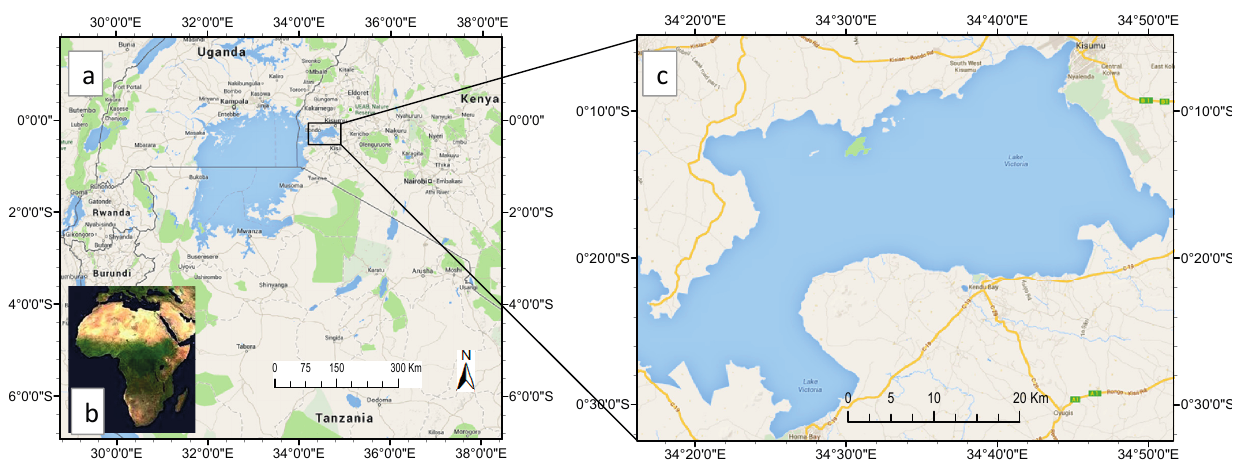
Figure 1. Geographic location of Lake Victoria in East Africa ( a ) and Africa ( b ), ( c ) Zoomed-in Winam Gulf section of the lake. Source: Google Maps